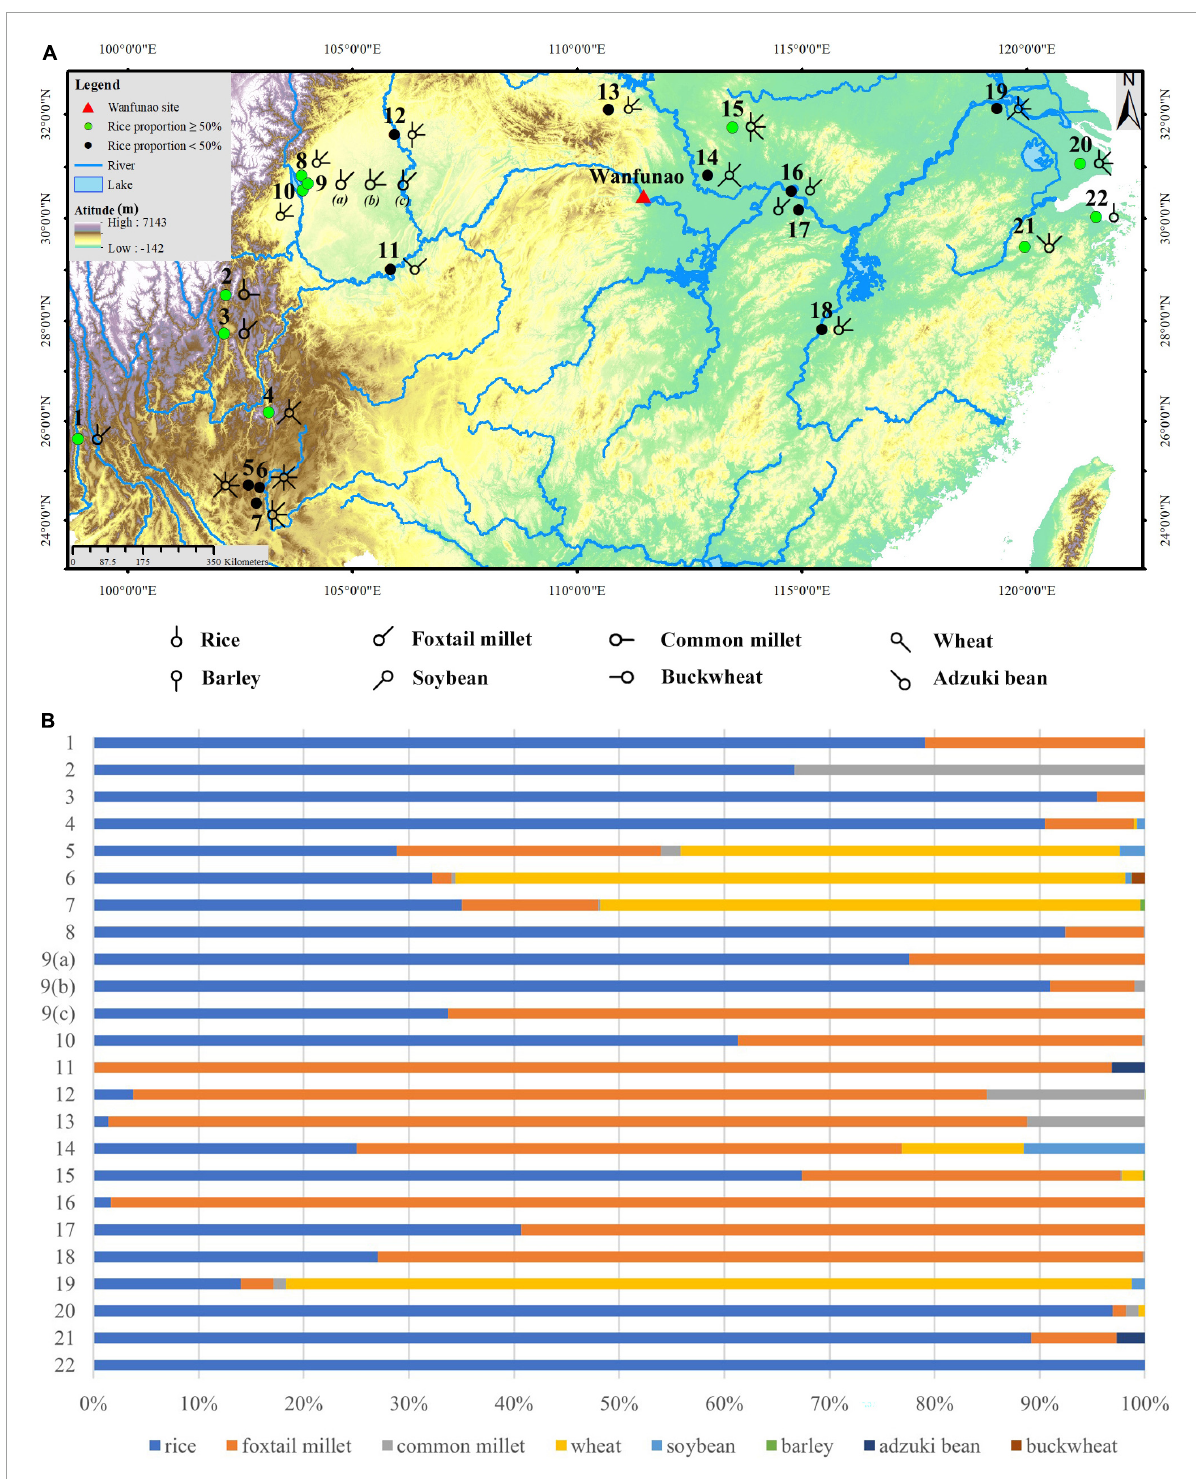
FIGURE7 Crop assemblage and proportion of Zhou Dynasty in the south of Yangtze River. (A) Crop assemblage; (B) carbonized crop proportion. (1) Shilinggang, (2) Gaopo, (3) Shapingzhan, (4) Yubeidi, (5) Heposuo, (6) Xueshan, (7) Guangfentou, (8) Boluocun, (9) Jinsha (a) Jinniu district No. 5, (b) Sacrificial area, and (c) Yangguangerqididai, (10) Sanguantang, (11) Handongcheng, (12) Zhengjiaba, (13) Jijiawan, (14) Qujialing, (15) Miaotaizi, (16) Chengzishan, (17) Xiezidi, (18) Niucheng, (19) Dingjiacun, (20) Guangfulin, (21) Shangshan, and (22)